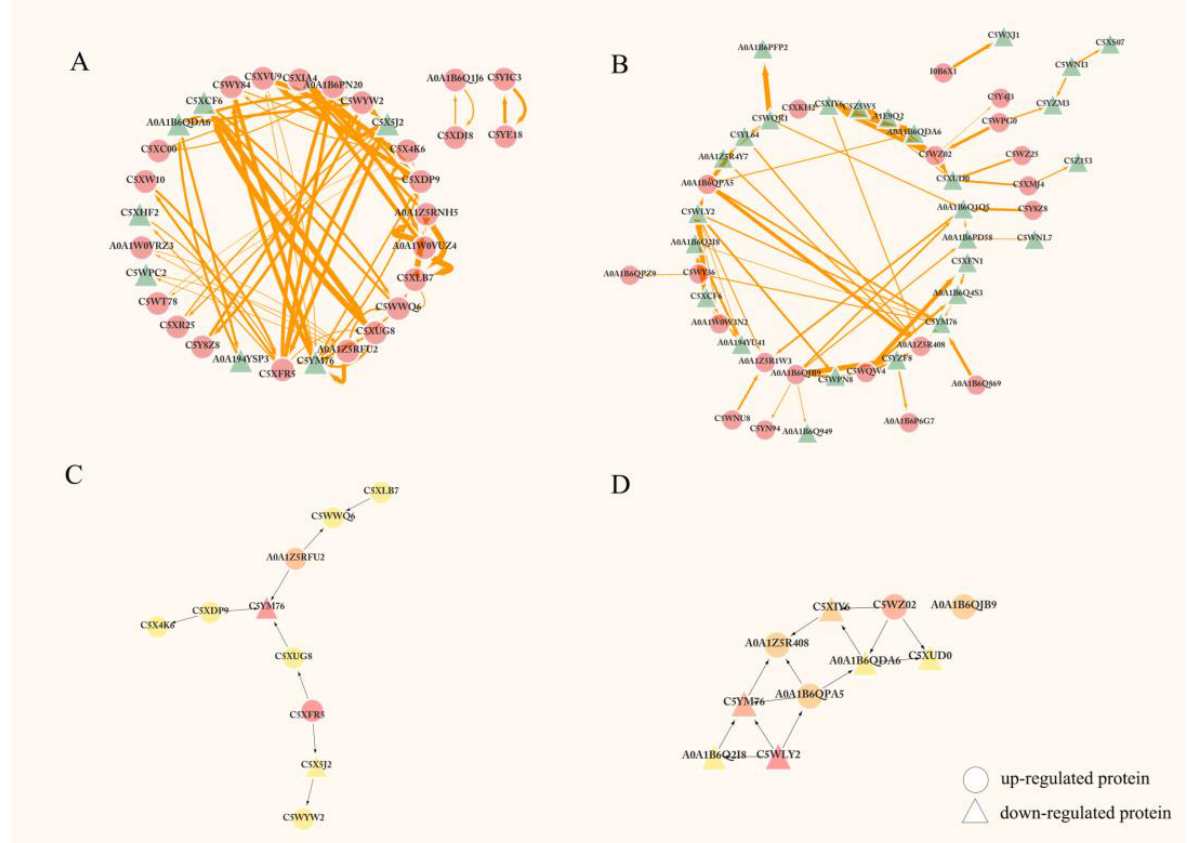
Figure 4. PPI network of 31 and 47 DAPs in drought-sensitive and drought-resistant sorghums, respectively. Functional correlation network of 31 DAPs of drought-sensitive sorghums ( A ). Functional correlation network of 47 DAPs of drought-resistant sorghums ( B ). The thickness of the connecting line between nodes represents the combined score value. The thicker it is, the stronger the interaction between the two proteins is. Green triangles and red circles represent down- and upregulated proteins in ( A ) and ( B ), respectively. The ( C ) and ( D ) represent the top ten DAP nodes in the networks of drought-sensitive sorghum and drought-resistant sorghums, respectively. The node color ranges from yellow to red, and the darker the node color, the more important it is in the interaction network. Triangles represent down-regulated proteins and circles represent up-regulated proteins in ( C ) and ( D ).